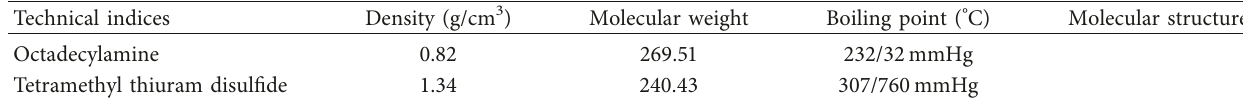
Table 3: Technical properties of graphene oxide.